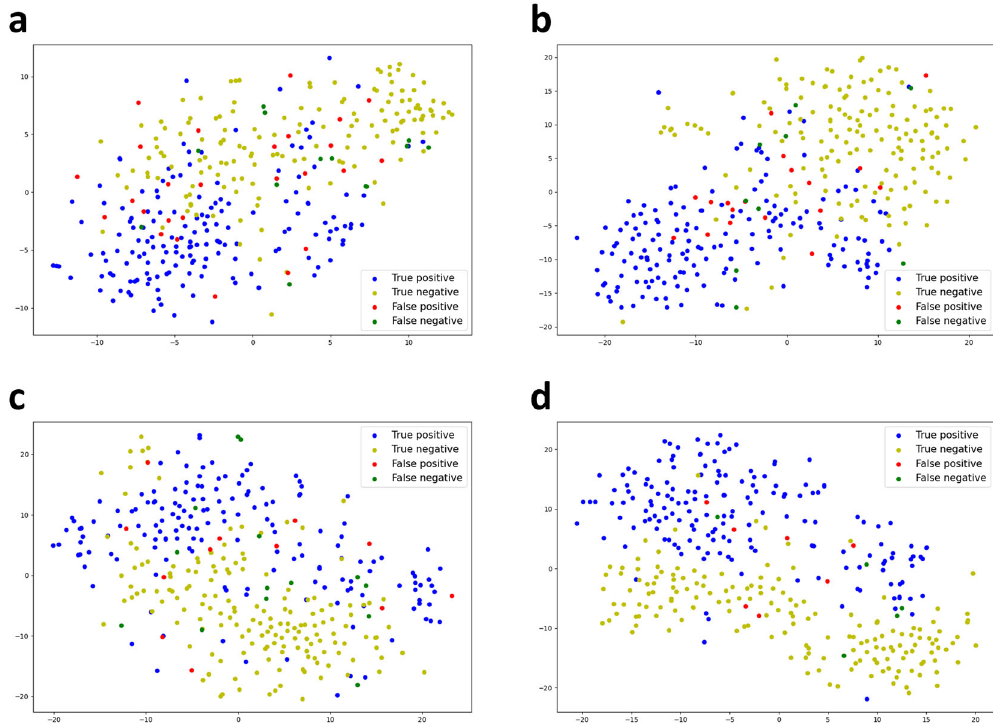
Fig. 4 t-SNE representation of the last activation map in the classi fi cation models. The t-SNE data distribution is included for ( a ) synthetic retardation, ( b ) real retardation, ( c ) synthetic DOPU, and (d) real DOPU images. The distribution of the classi fi ed synthetic PS-OCT images resembles the distribution of the real PS-OCT